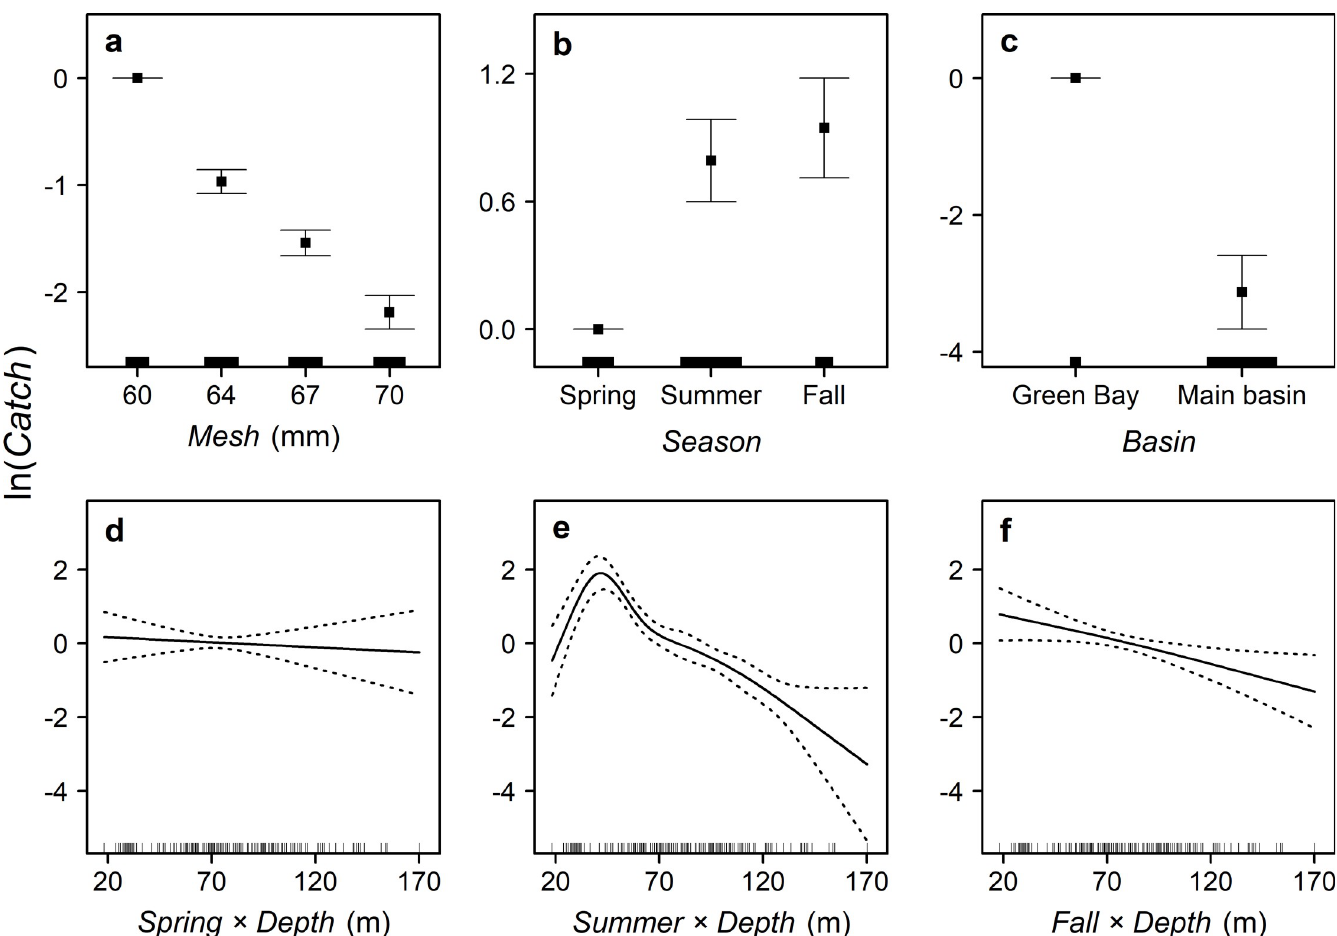
Fig 4. The relationships between number of cisco caught ( Catch ) and gill-net mesh size ( Mesh ), season ( Season ), habitat type ( Basin ), and bottom depth ( Depth ), with adjustments for sampling effort and spatial variability, based on the selected generalized additive model fitted to the Fulmar data. The points in panels a–c and solid lines in panels d–f represent the predicted values. The error bars in panels a–c and dotted lines in panels d–f represent +/ − one standard error. Ticks above the horizontal axis represent the relative sample size in panels a–c and the distribution of data points in panels